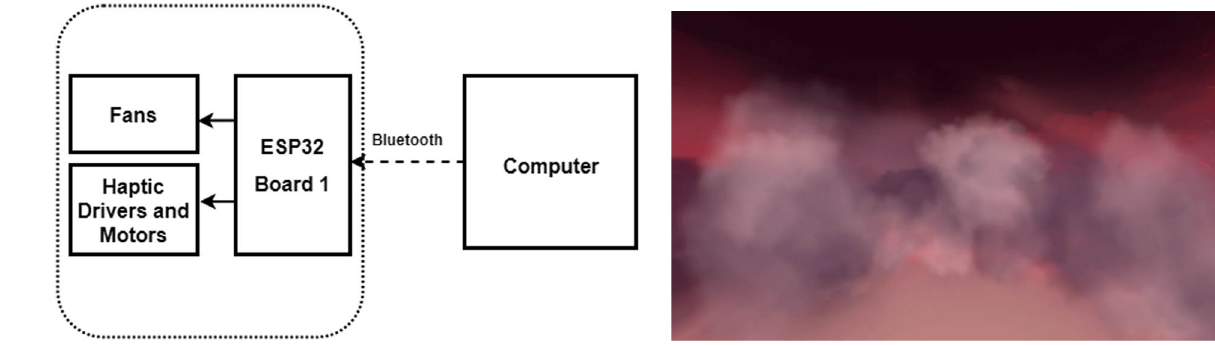
Figure 4: Screenshot of Intro VMSE fi rst part taken from Oculus